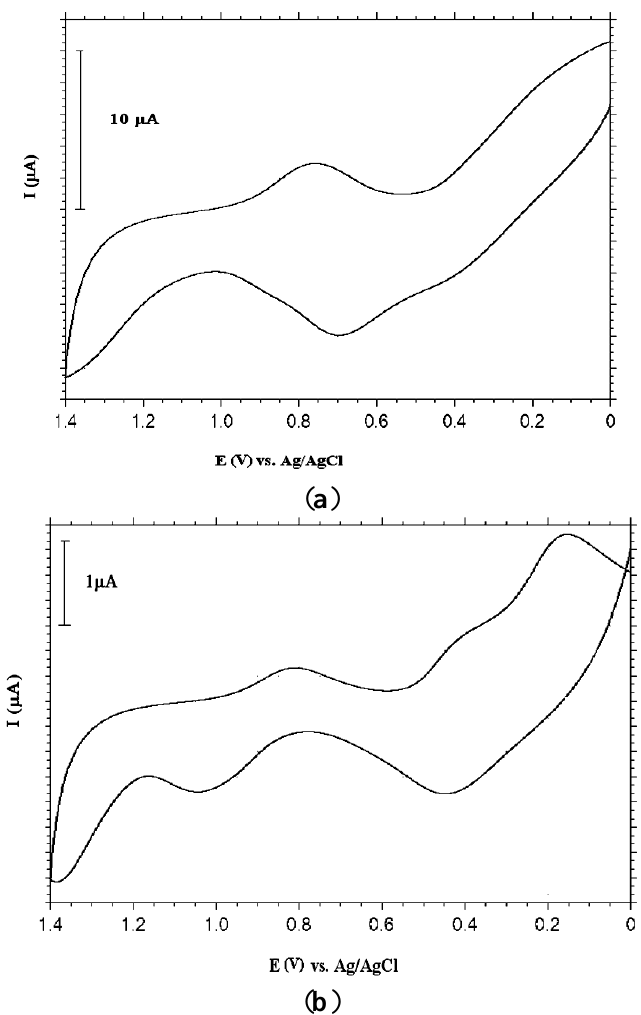
CV measurement : at 50 mV/s scan rate between 0.0 V and +1.4